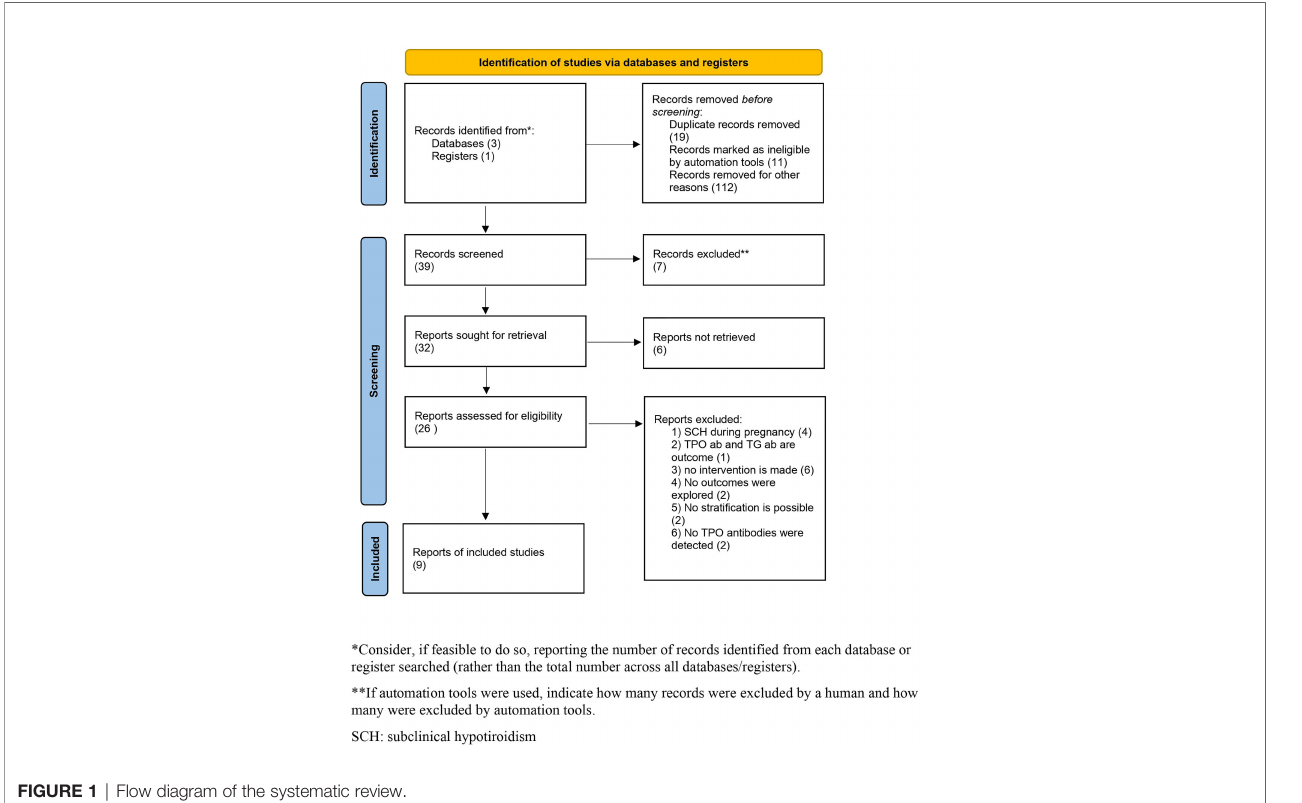
TABLE 2 | Pooled Odds ratio (OR) for the different categorical outcome explored in the present systematic review in euthyroid women having compared to those not having LT4 supplementation. Outcome